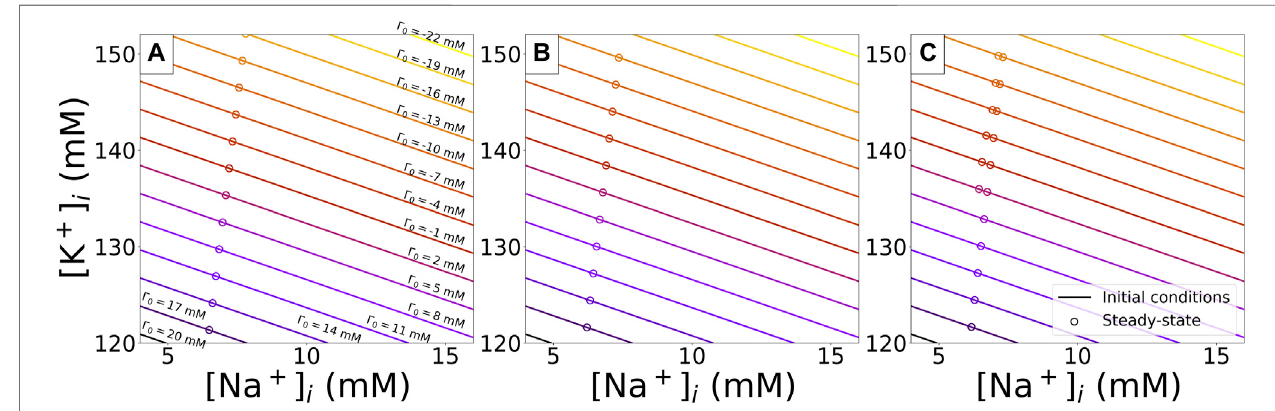
FIGURE 10 | Limit cycle concentrations of [ K + ] i and [ Na + ] i for simulations with ORd-CiPA model starting from different initial conditions. Each line corresponds to combinations of intracellular concentrations bound by a single Γ 0 value. For each value of Γ 0 , 10 combinations of [ K + ] i and [ Na + ] i are used to sample the whole physiological range reported in Section 3.2 . Limit cycle concentrations of the 10 combinations are marked by circles, with colour matching the initial conditions. For I Kr reduction up to 90%, a unique limit cycle can be reached per value of Γ 0 . In the case of 95% of I Kr reduction, two distinct limit cycles can be observed for higher intracellular concentrations. (A) : With no I Kr reduction. (B) : With 90% I Kr reduction. (C) : With 95% I Kr reduction.